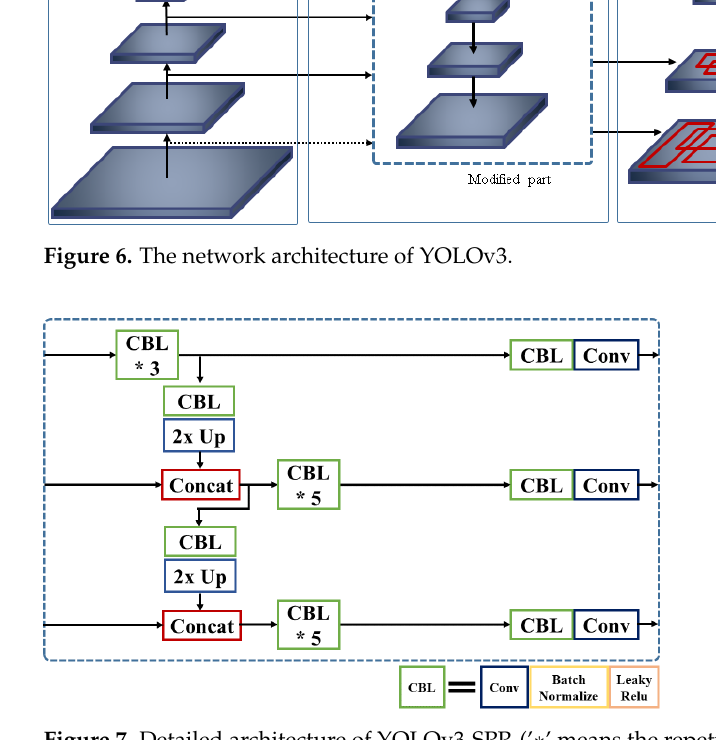
Figure 7. Detailed architecture of YOLOv3-SPP. (’ ∗ ’ means the repetition of